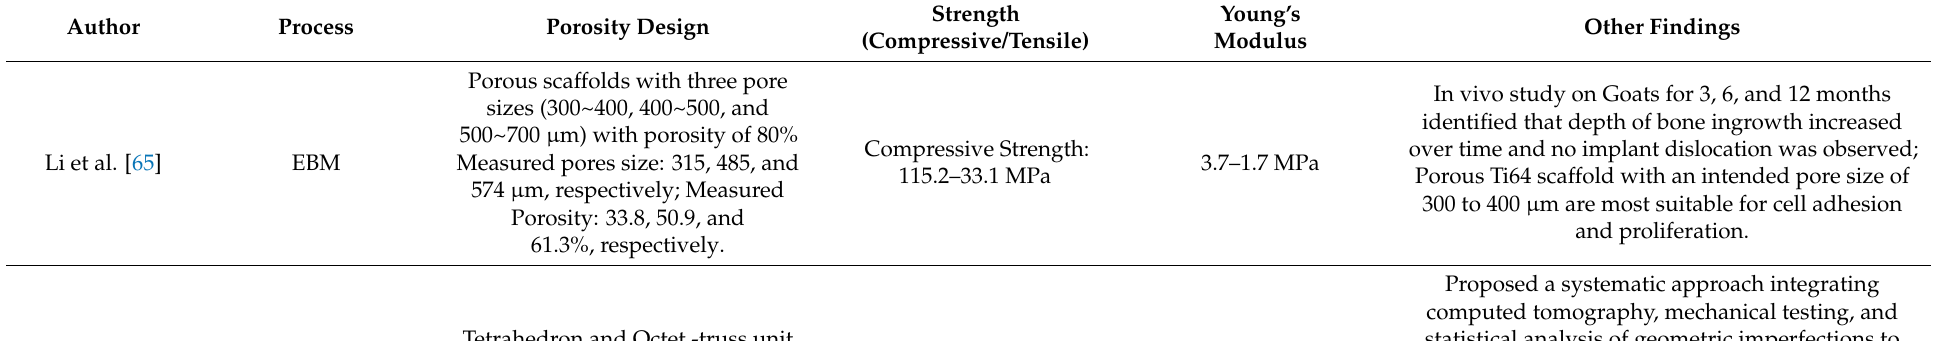
Table 2. Mechanical Properties of Non-Gradient Porous